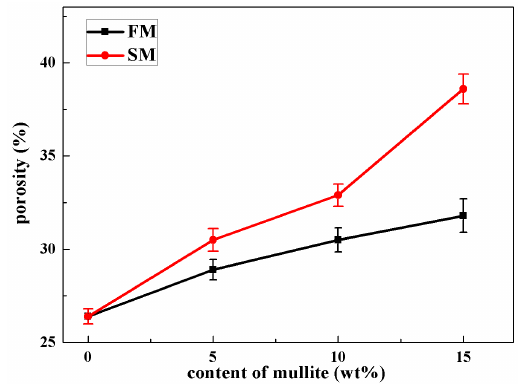
Figure 6. Apparent porosity of ceramic cores with different mullite contents.